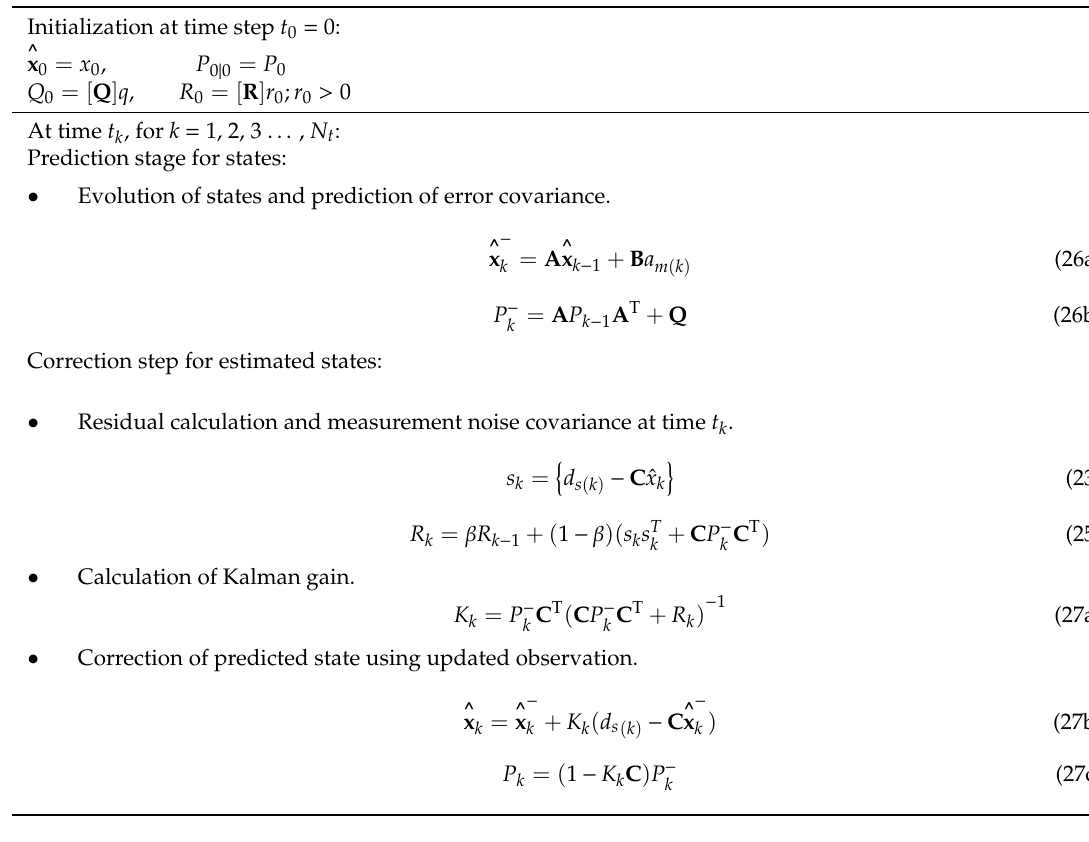
Table 1. Implementation scheme for the